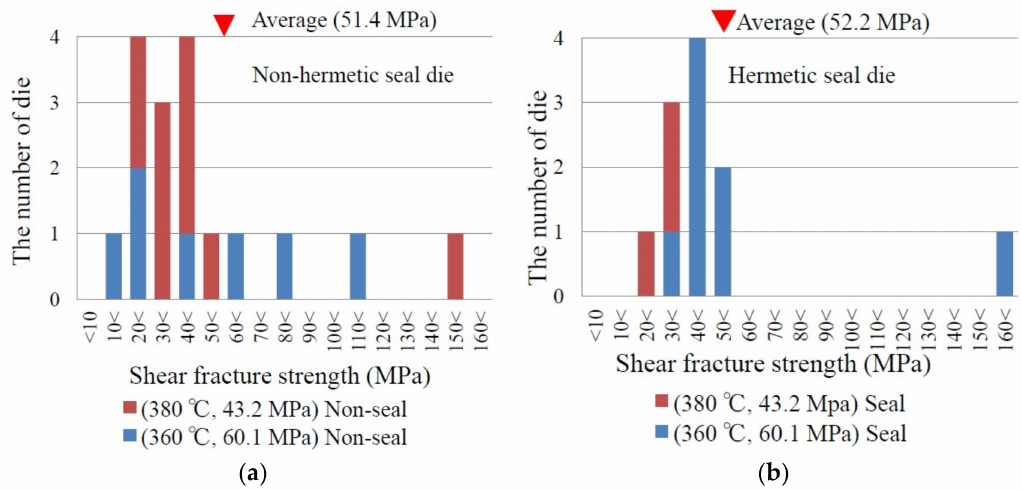
Figure 4. Distribution of shear fracture strength for ( a ) non-hermetic dies and ( b ) hermetic dies. The bonding temperature and pressure, as well as the average of shear fracture strength are shown in each